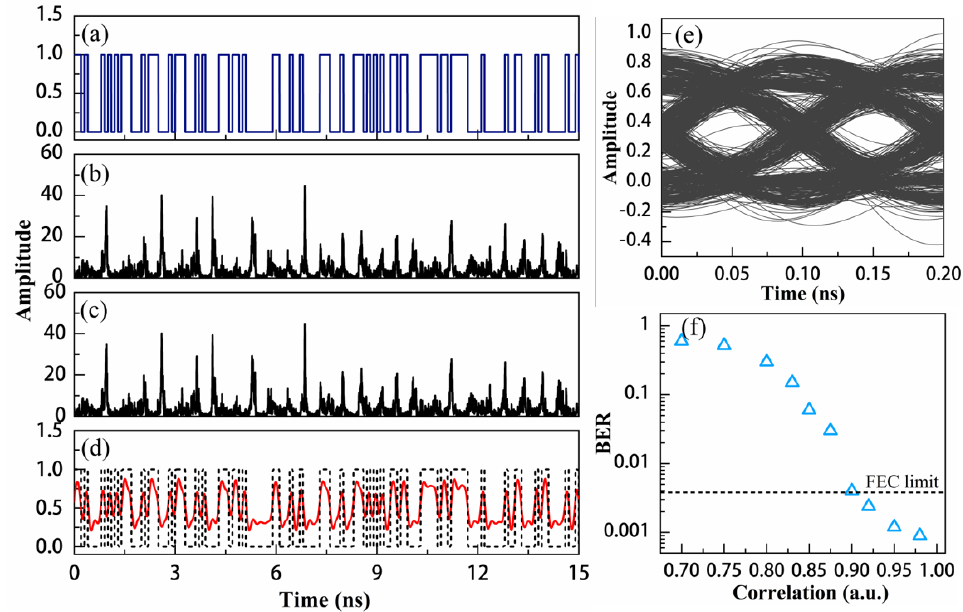
Figure 6. Time series for ( a ) original message, ( b ) chaotic carrier, ( c ) chaotic carrier with message, and ( d ) decrypted message. ( e ) Eye diagrams for decrypted message; ( f ) BER of decoded message as a function of synchronization coefficient. The message rate is 10 Gbit/s with a modulation amplitude of 0.2.